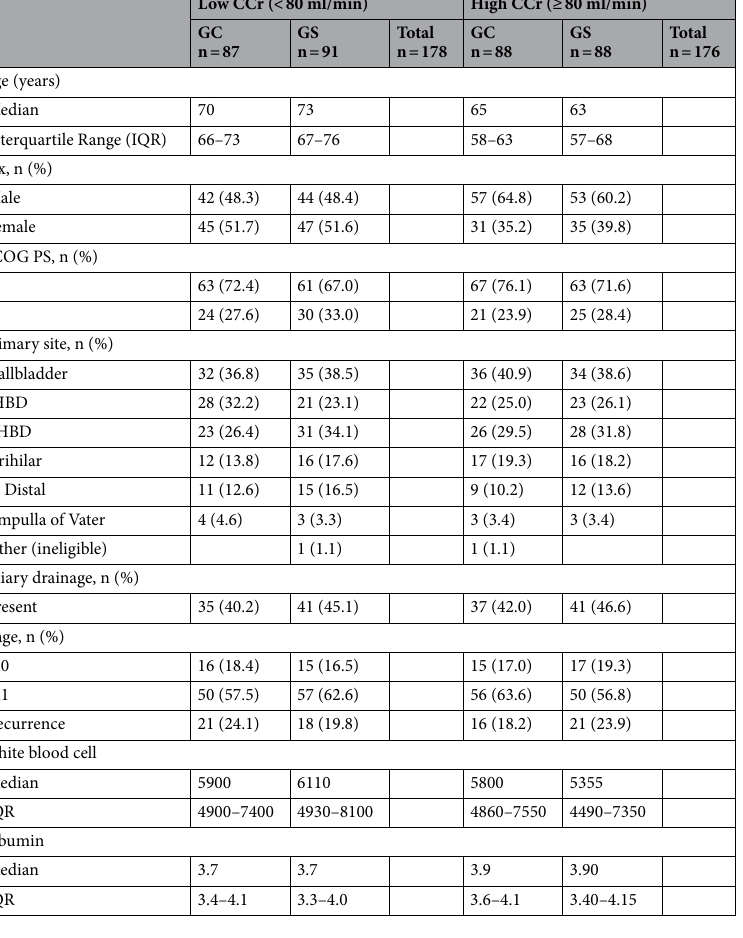
Table 1. Patient characteristics in the high and low CCr groups (n = 354). CCr creatinine clearance, ECOG PS Eastern Cooperative Oncology Group performance status, EHBD extrahepatic bile duct, GC gemcitabine